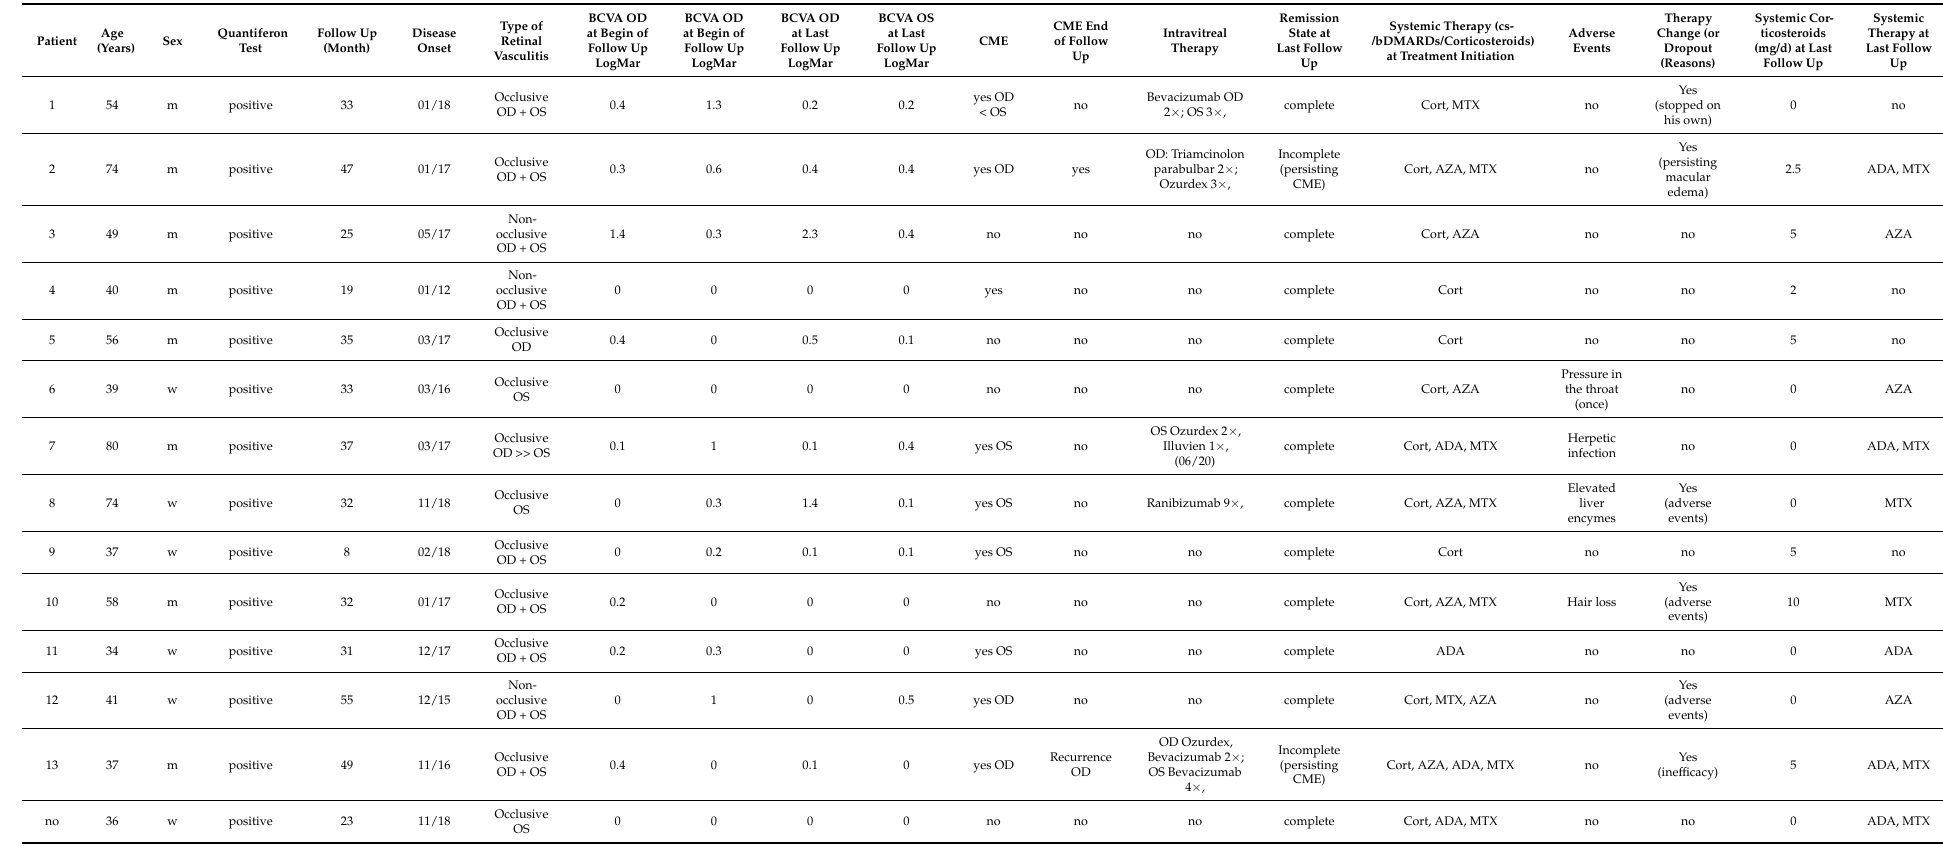
Table 1. Shows the age, duration of therapy, BCVA before and after treatment, treatment, adverse events, intravitreal therapy, and if macula edema was present. Cort = corticosteroids, MTX = Methotrexate, AZA = Azathioprin, ADA = Adalimumab. OD: oculus dexter, right eye; OS: oculus sinister, left